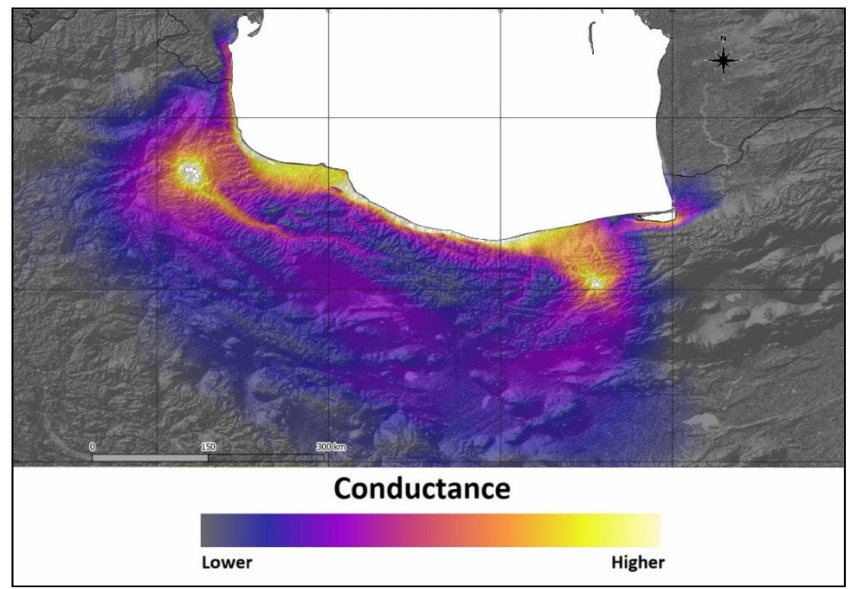
Figure 4. Theoretical gene flow between populations of Sorbus aucuparia in relation to the topography determined using